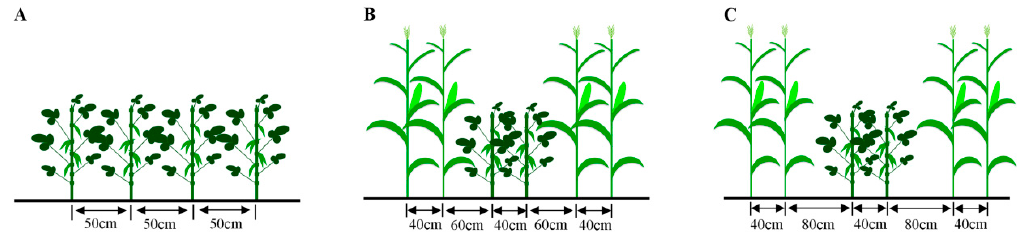
Figure 2. Spatial configurations of each treatment in the field experiment from 2015 to 2017, including soybean monoculture ( A ) and two bandwidth intercropping treatments, INT1 ( B ) and INT2 ( C